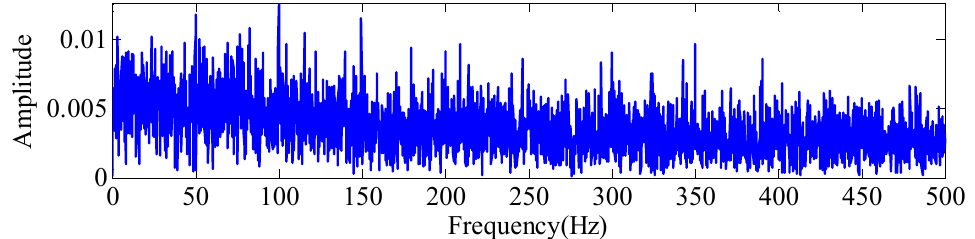
Figure 7. The envelope spectra of the simulated signals.